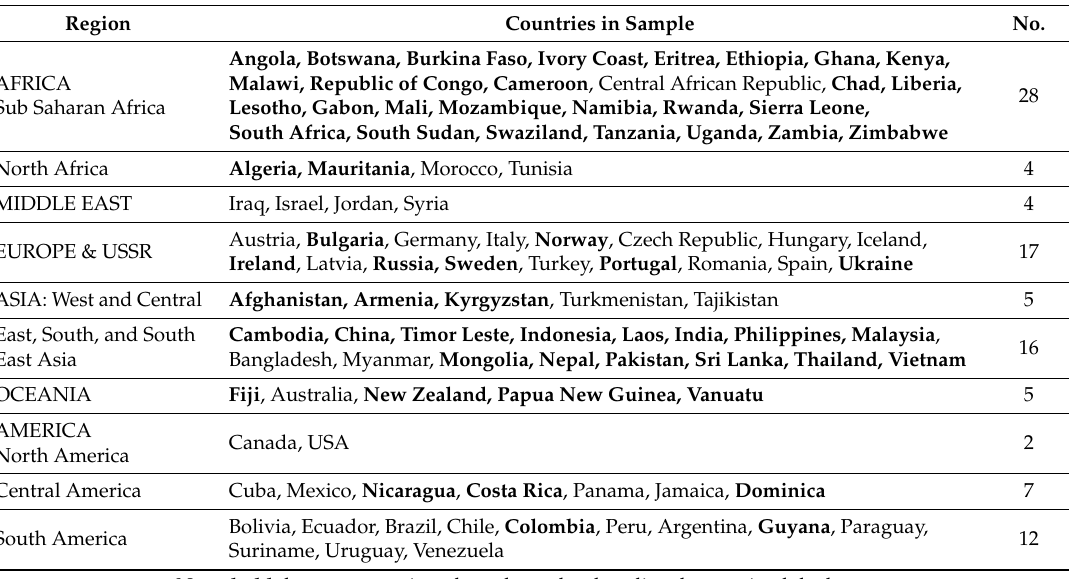
Table 1. The Sample: Countries Assessed for National Law Provision for Community Property. Region Countries in Sample No.